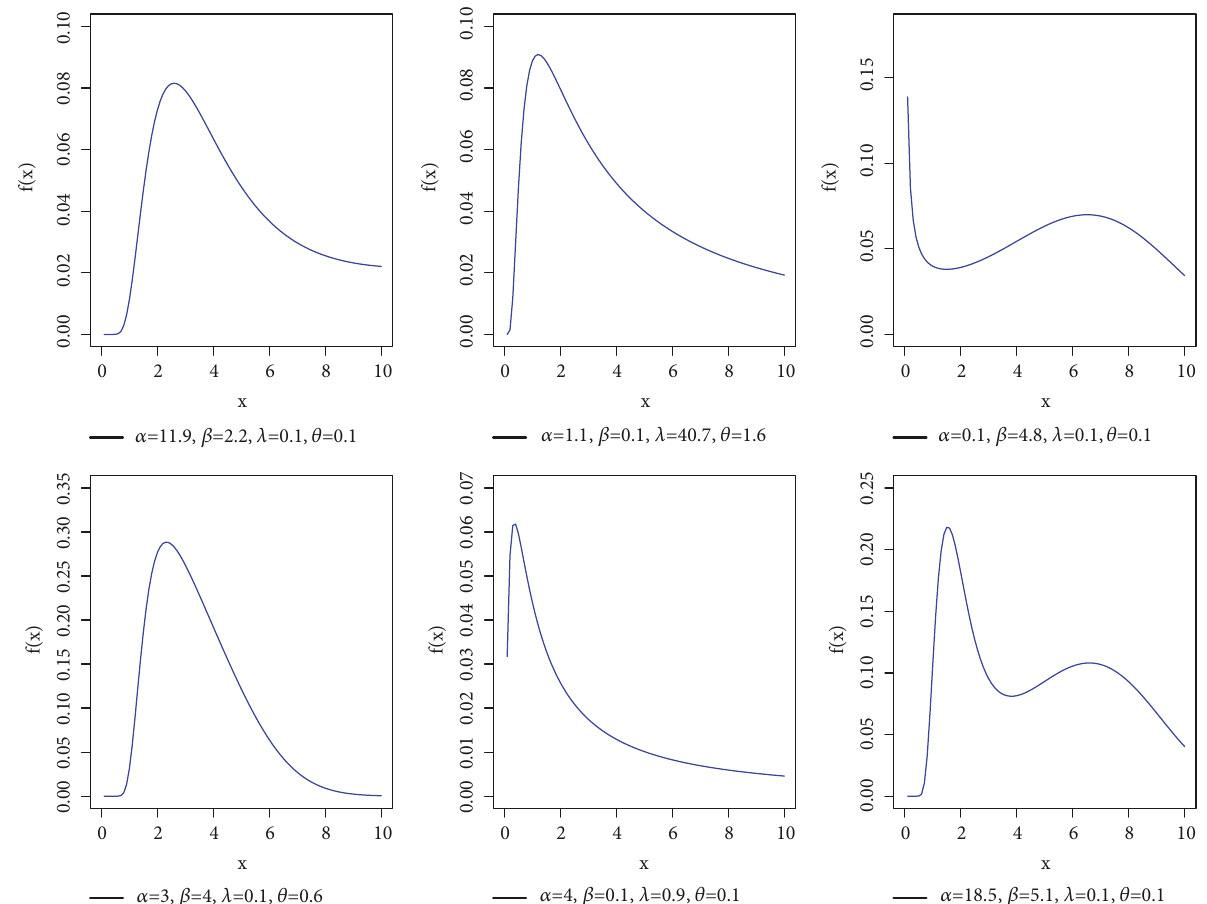
Figure 1: Plots of the EOFNH distribution density